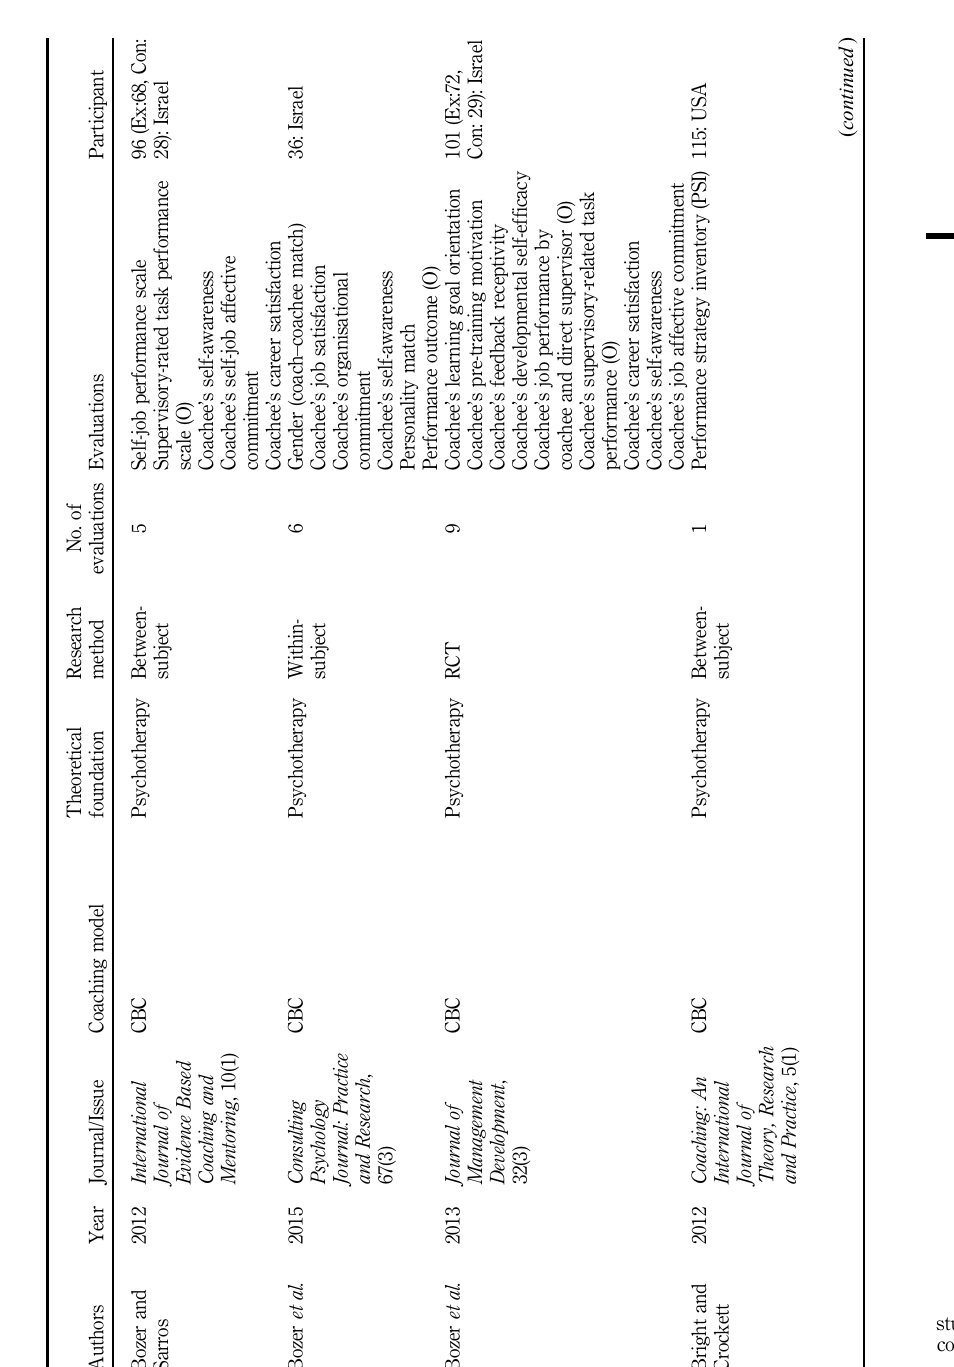
studied psychological coaching